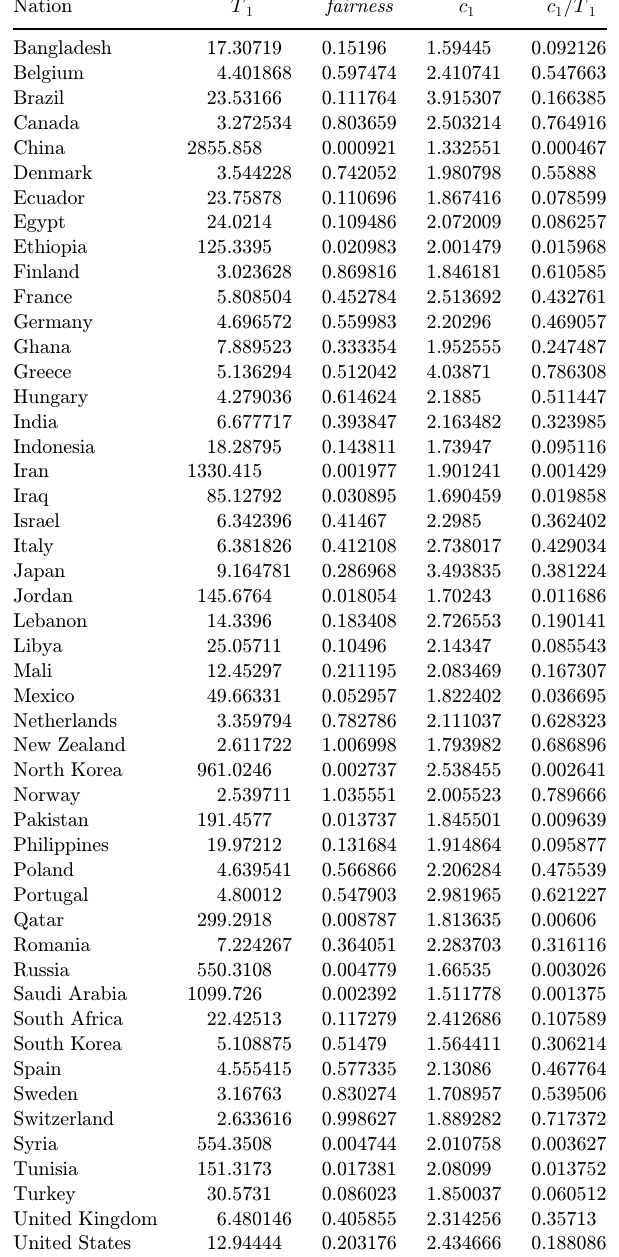
Table 2. List of 49 nations with their c 1 , ~ T 1 , fairness , and c 1 = ~ T 1 values taken from Ref.